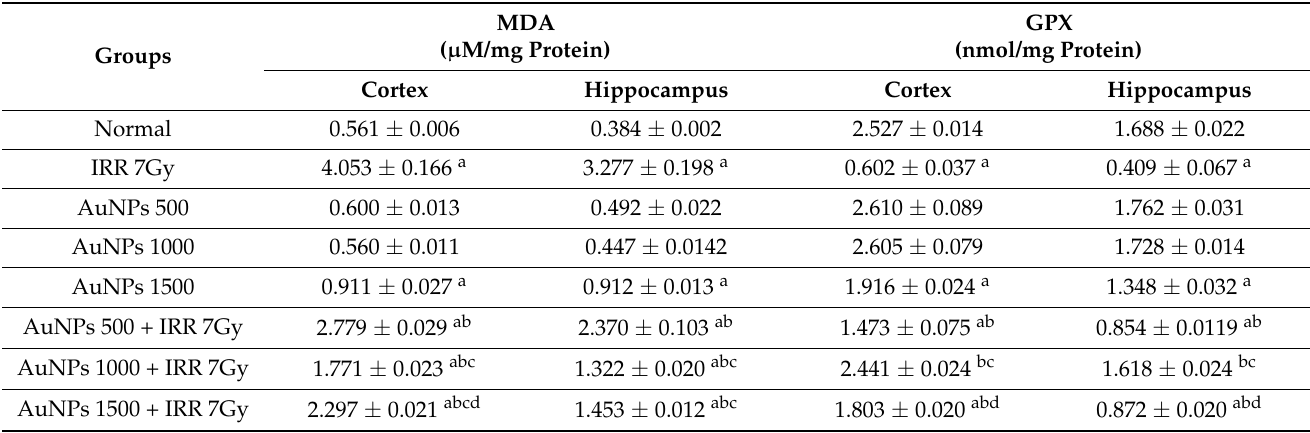
Table 1. Effect of single oral administration of different doses of AuNPs on MDA content and GPX activity in cortical and hippocampal tissues of 7Gy-irradiated